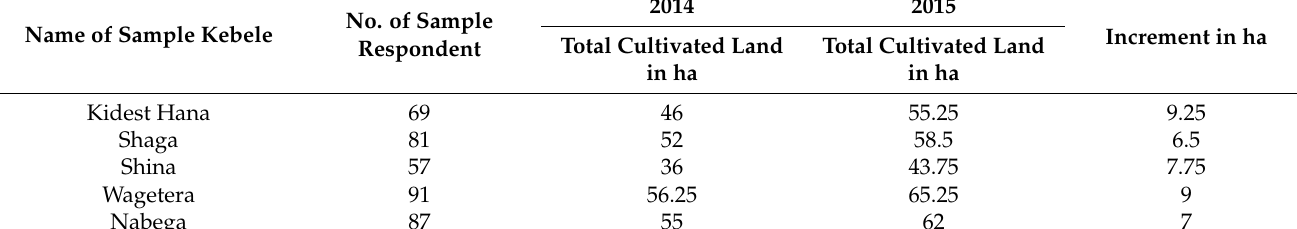
Table 3. The rice cultivated area for the year 2014 and 2015.